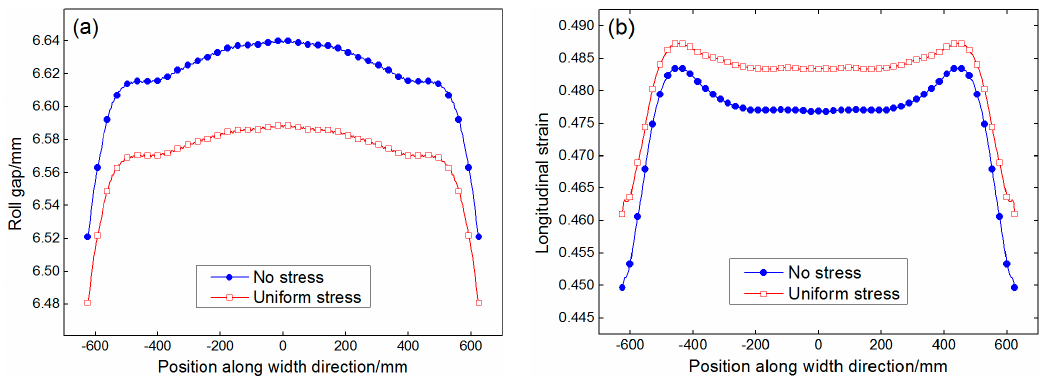
Figure 12. Effect of uniform stress on the roll gap profile and longitudinal strain: ( a ) effect on the roll gap profile; and ( b ) effect on the longitudinal strain.